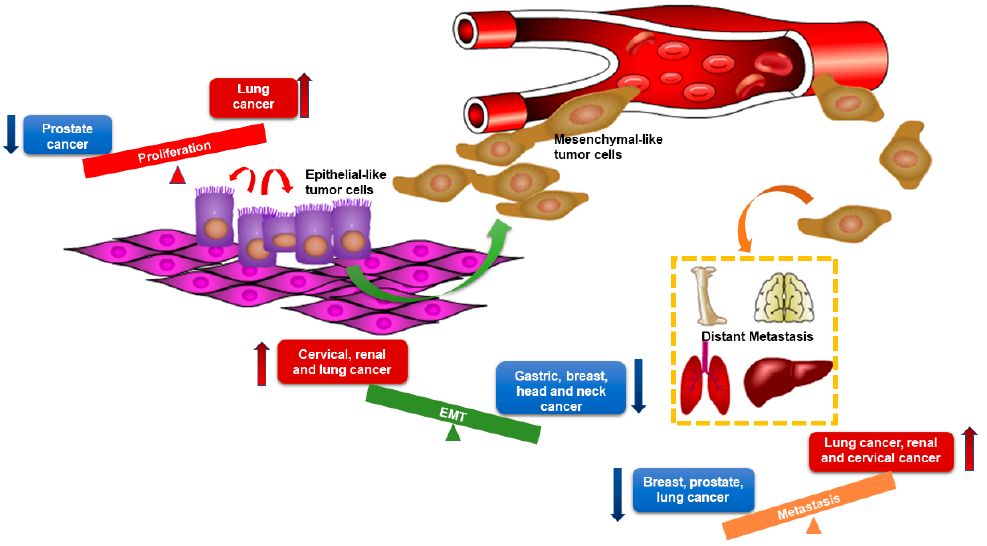
Figure 2. The distinct roles of miR-205-5p in different types of cancers. Red arrows represent the facilitating effects of miR-205-5p and blue arrows represent the suppressive effects of miR-205-5p. The graph shows opposite roles of miR-205-5p in tumor proliferation, epithelial–mesenchymal transition (EMT), and metastasis among di ff erent types of cancers. MiR-205-5p exerts promoting e ff ects in cancers listed in red boxes and exerts suppressive e ff ects in cancers listed in blue